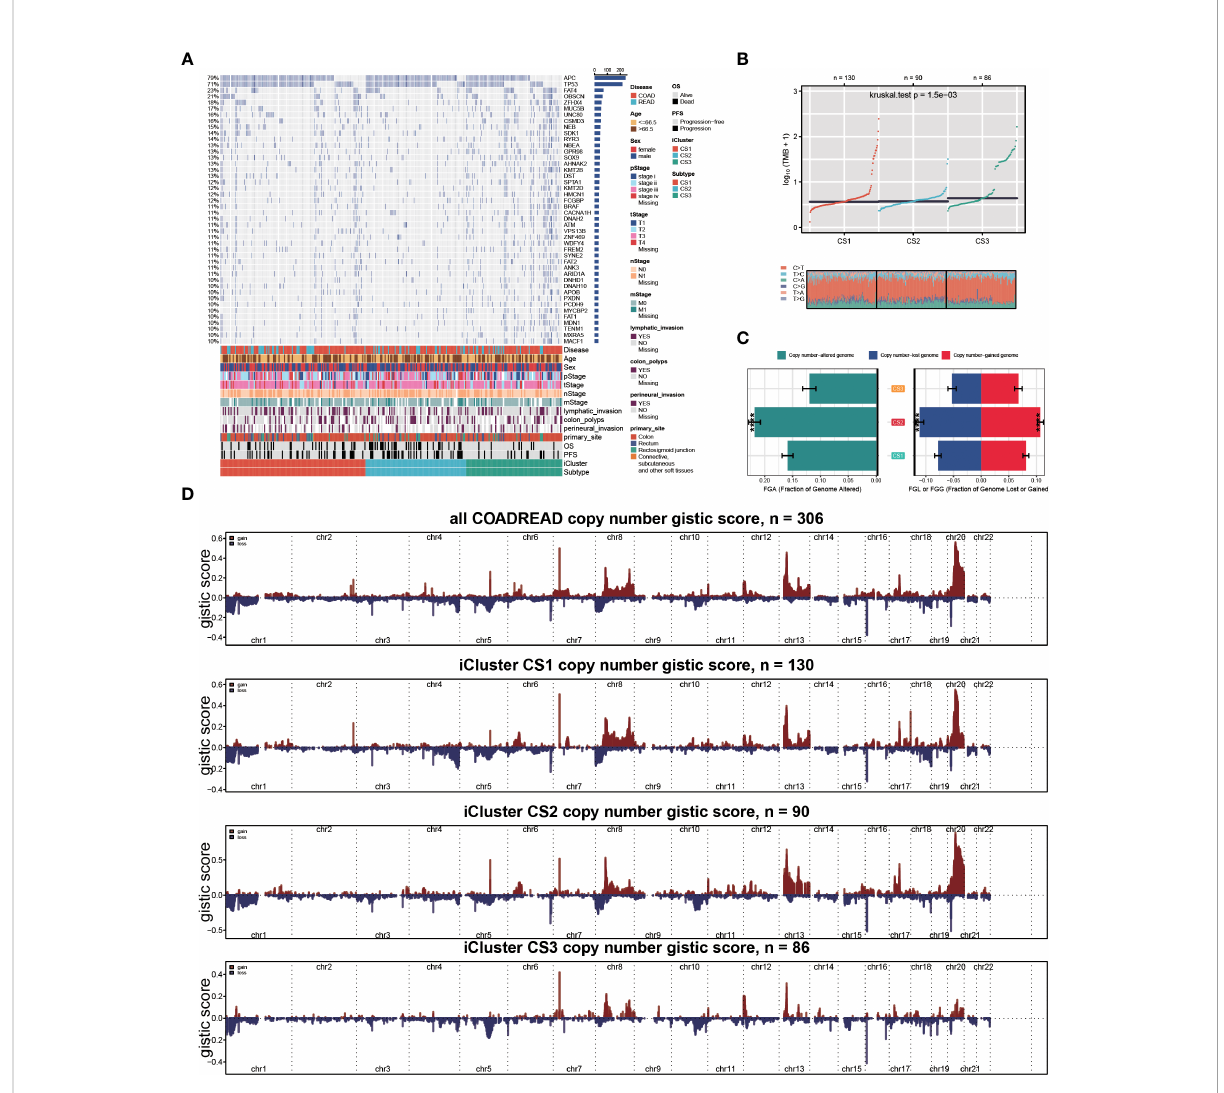
FIGURE 2 Genomic heterogeneity of colorectal cancer subtype. (A) OncoPrint showing the distribution of genes that were differentially mutated between three cancer subtypes. (B) Distribution of TMB and TiTv (transition to transversion) between two epigenetic phenotypes. (C) Barplot showing the distribution of FGA and fraction genome gain/loss (FGA/FGG). Bar charts are presented as the mean ± standard error of the mean. (D) three types distinguishing composite copy number.